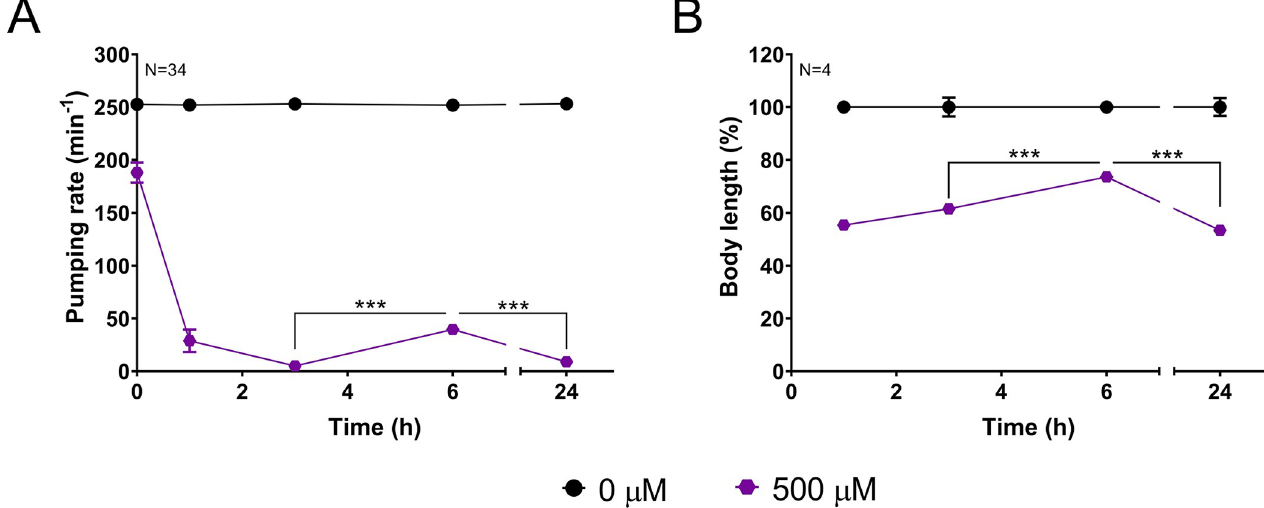
Fig 4. Pharyngeal and body wall neuromuscular behaviours exhibit a paraoxon-ethyl intoxication pattern characterized by three phases, an initial inhibition, a spontaneous in drug recovery and a subsequent inhibition. A) Pharyngeal pumping in nematodes exposed to 500 μ M paraoxon-ethyl display a complete inhibition of pumping at 3 hours and an in-drug recovery at 6 hours. The complete inhibition of pumping is observed after 24 hours of exposure. Data are shown as mean ± SEM of 34 worms in at least 17 independent experiments (N = 34). B) Nematodes were exposed to 500 μ M paraoxon-ethyl and body length recorded 1, 3, 6 and 24 hours of exposure. Percentage of body length was referenced against the corresponding age-matched untreated control. Similar to pumping the three phases of intoxication were observed encompassing: initial shrinkage of nematodes at 1 hour, spontaneous body length recovery after 6 hours and the subsequent shrinkage of length at 24 hours of exposure. Data are shown as mean ± SEM of 6 worms in 4 independent experiments (N = 6). Statistical significance was calculated by two-way ANOVA test followed by Bonferroni corrections. ** p � 0.01; *** p � 0.001.